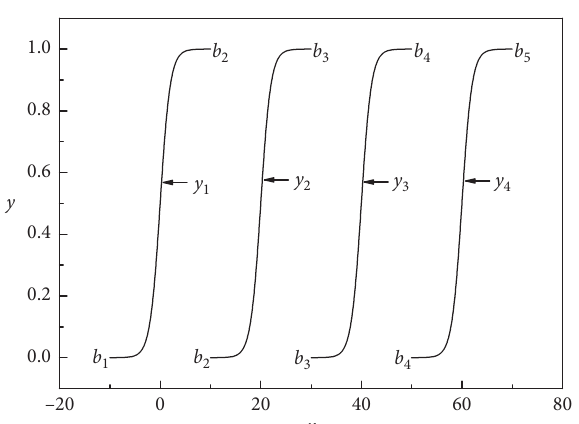
Figure 5: Diagram of the logistic function after translation.